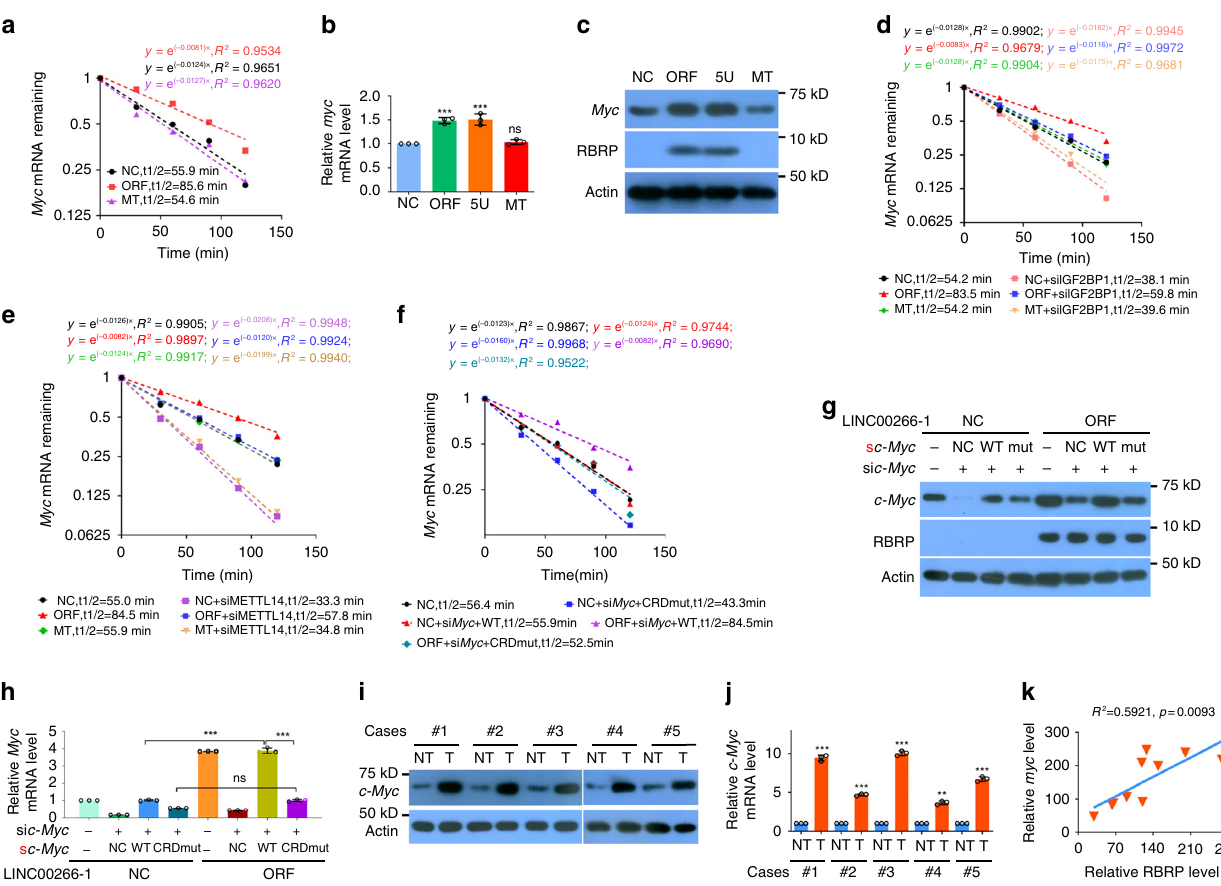
Fig. 6 RBRP increases the stability and expression of c-Myc mRNA by regulating the m 6 A recognition by IGF2BP1 on c-Myc CRD mRNA. a – c RBRP overexpression, but not the lncRNA LINC00266-1 itself, increases the half-life ( a ) ( n = an experiment) and level ( b ) ( n = 3 independent experiments) of c- Myc mRNA and the c -Myc protein level ( c ) in the cells stated in Fig. 5a. d , e The enhancement of the c-Myc mRNA half-life induced by RBRP (ORF) was blocked by silencing either the m 6 A reader IGF2BP1 ( d ) or the m 6 A writer METTL14 ( e ) in the cells stated in Fig. 5a ( n = an experiment). f – h Cells were treated as in Fig. 5h. RBRP overexpression did not increase the c-Myc mRNA half-life ( f ) ( n = an experiment) or level ( h ) ( n = 3 independent experiments), or the c-Myc protein level ( g ) when A was mutated to U within six m 6 A consensus sites in c-Myc mRNA CRD. i , j The c-Myc protein ( i ) and mRNA ( j ) ( n = 3 independent experiments) levels were determined in the CRC tissue samples shown in Fig. 2c. The c-Myc protein and mRNA levels were increased in CRC tissues (T) compared with those in the corresponding NT. k The c - Myc protein levels were positively correlated with the RBRP oncopeptide levels in the clinical tissue samples ( n = 10 samples) using linear regression analysis. Two-tailed unpaired Student ’ s t -test unless speci fi cally stated. The data are represented as the means ± SD. * p < 0.05, ** p < 0.01, or *** p < 0.001, ns indicates no signi fi cance. Source data are provided as a Source Data fi on RNAs and promotes c-Myc mRNA stability and tumorigenesis through IGF2BP1. Therefore, we further examined whether RBRP promotes tumorigenesis and c-Myc mRNA stability in an IGF2BP1-binding-dependent manner. The expression of the WT RBRP or the IGF2BP1-binding-defective mutant RBRP G19A, which is resistant to the LINC00266-1 shRNA that targeted the 3 ′ - UTR of the RBRP ORF, was restored in CRC cells with stable knockdown of LINC00266-1 . Knockdown of LINC00266-1 sig- ni fi cantly decreased the c-Myc mRNA stability and level, cell growth, colony formation, migration, and invasion, whereas these alterations were restored to the control levels in cells cotrans- fected with WT RBRP but not with the IGF2BP1-binding- defective mutant RBRP G19A (Fig. 7), indicating that RBRP promotes tumorigenesis and c-Myc mRNA stability by binding to